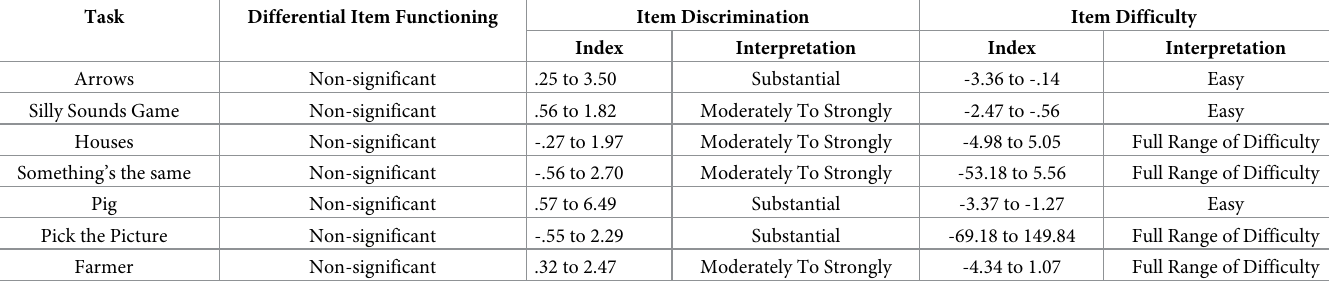
Table 3. Differential item functioning & item parameter estimation of each EF